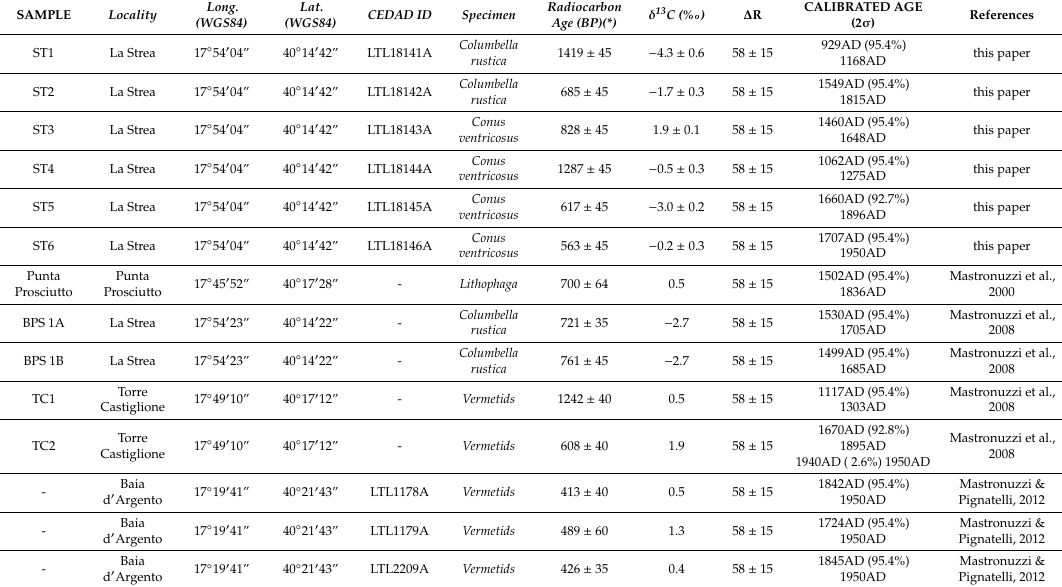
Table 2. AMS radiocarbon age determinations performed on samples collected at Profile S1 of the sand ridge (ST1–ST6) and reported in literature for samples coming from Profile S2 (BPS 1A and BPS 1B) along with chronological data related to large-size boulder accumulations detected along several sites along the Ionian coast of Apulia (Punta Prosciutto, Torre Castiglione: Samples TC1 and TC2, Baia d’Argento: Samples LTL1178A, LTL1179A and LTL2209A) [7,12,27]. See Figure 2 for site